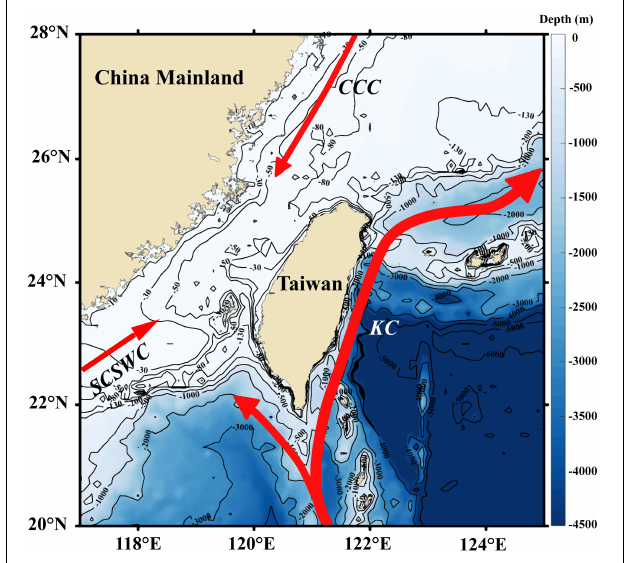
FIGURE 1 | Map of the coastal and offshore waters of Taiwan. CCC, China Coastal Current; SCSWC, South China Sea Warm Current; KC, Kuroshio Current.